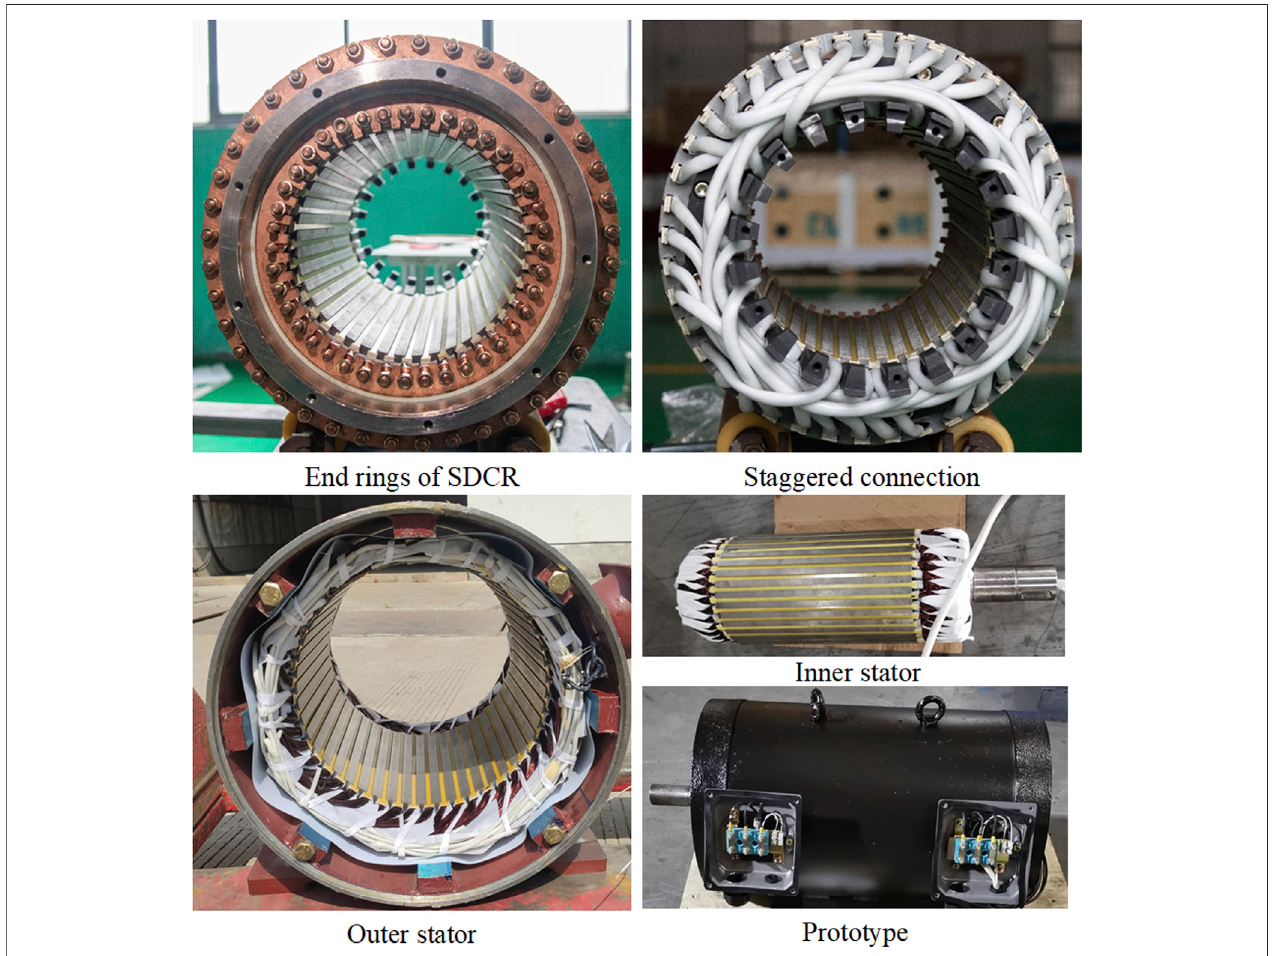
FIGURE 9 | Prototype of DS-BDFIM-SDCR with sum